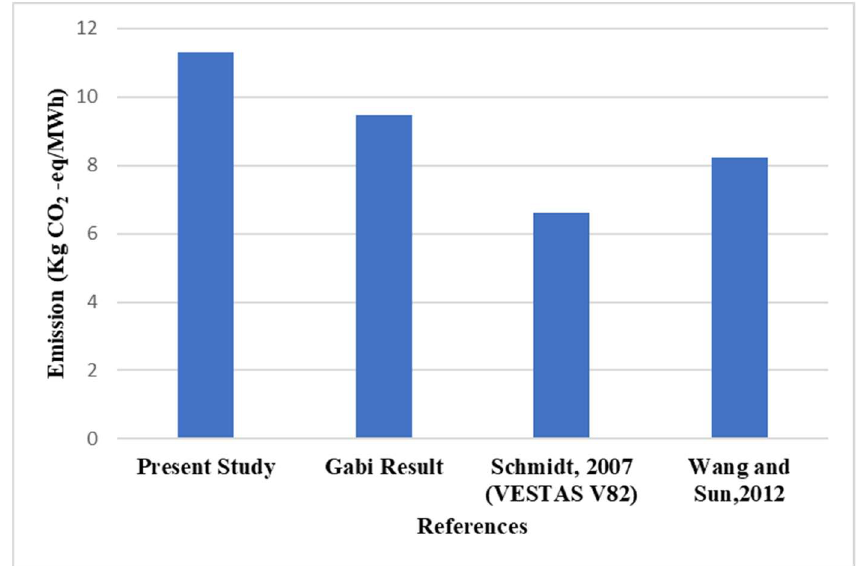
Figure 5. Comparison of CO 2 emissions from 1.65 MW wind turbine for a wind farm [35,57].